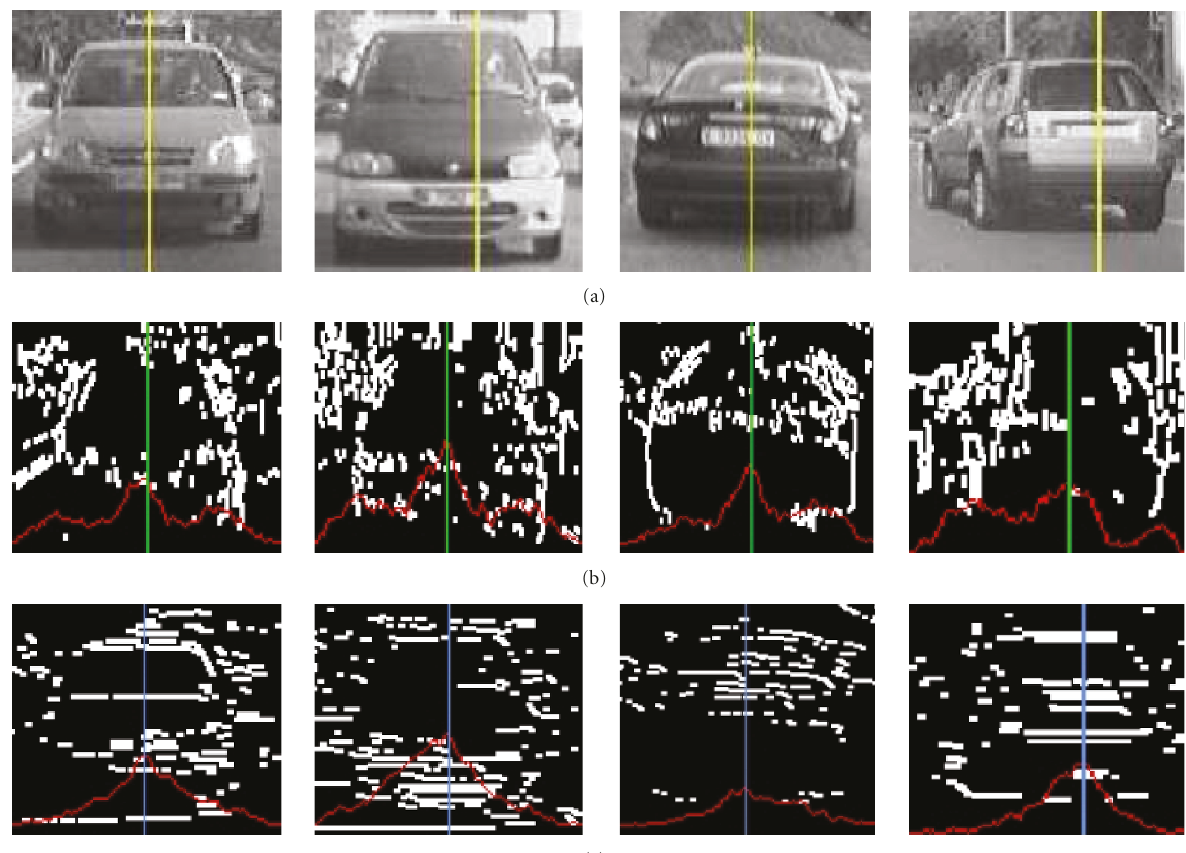
Figure 10: Upper row: gray level symmetry; Middle row: vertical edges symmetry; Lower row: horizontal edges symmetry.